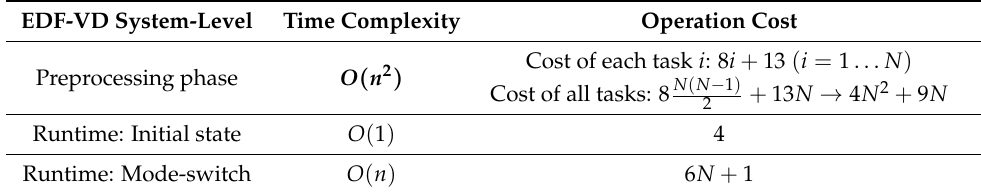
Table 3. Time and space complexity of Algorithm